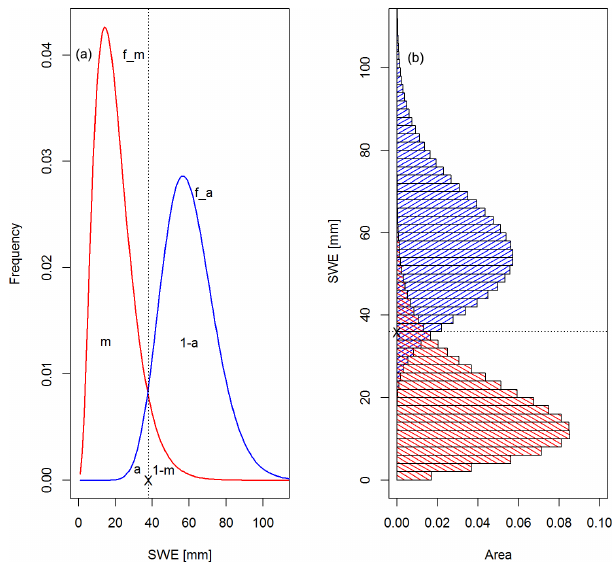
Figure 2. Schematic of how changes in SCA are estimated. (a) f m and f a are the spatial frequency distributions (PDF) of snowmelt and accumulation respectively. m , 1 − m , a and 1 − a are partially integrated values of the PDFs. (b) The integral of the PDFs for suc- cessive intervals of SWE and melt and their spatial coverage. The cross-hatched bars constitute the reduction in